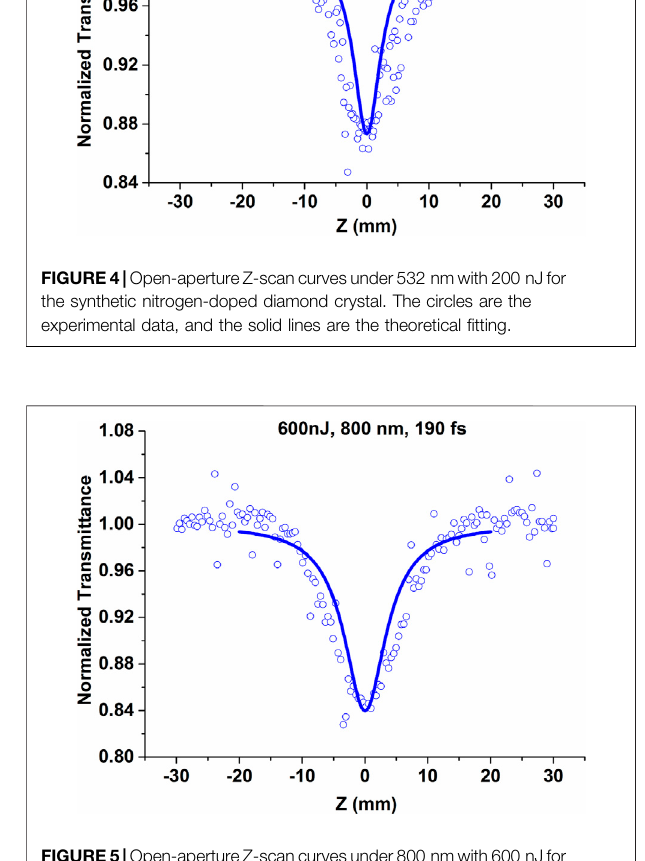
FIGURE5| Open-apertureZ-scancurvesunder800 nmwith600 nJfor the synthetic nitrogen-doped diamond crystal. The circles are the experimental data, and the solid lines are the theoretical fi